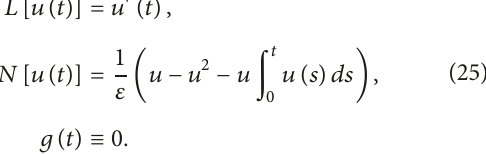
with the initial condition 𝑢(0) = 0.1 . Here we aim to solve the above Volterra population equation for the value 𝜀 = 1/10 .